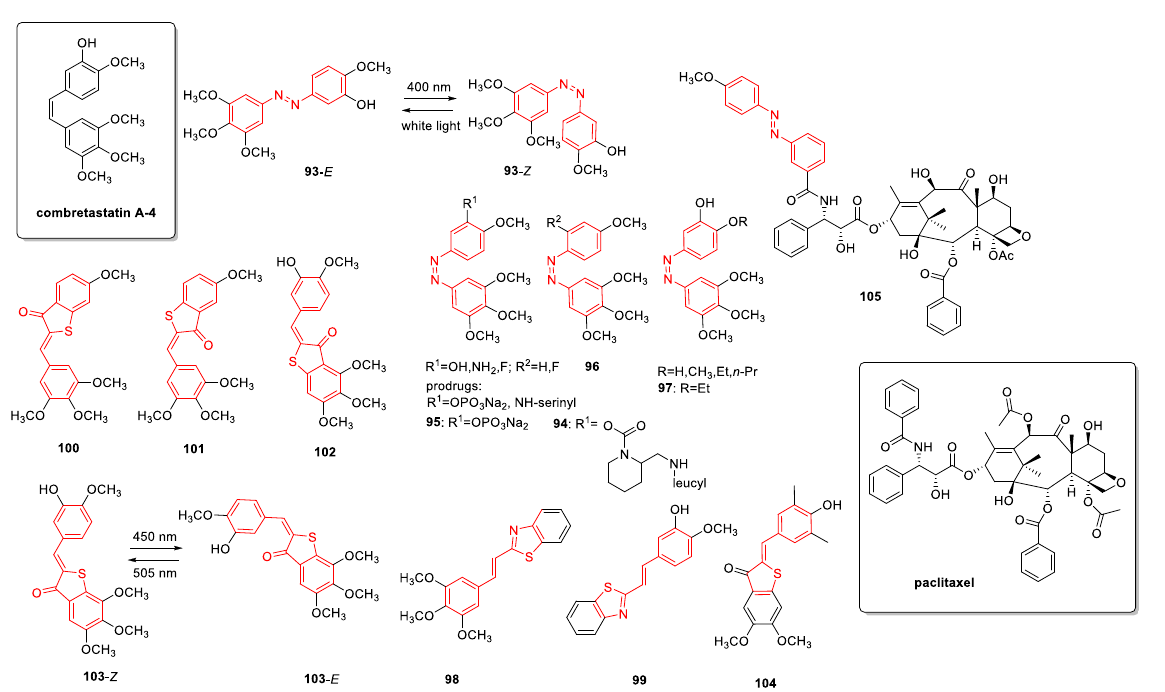
Figure 17. Photoswitchable microtubule-targeting agents, the photoswitch unit indicated in red.